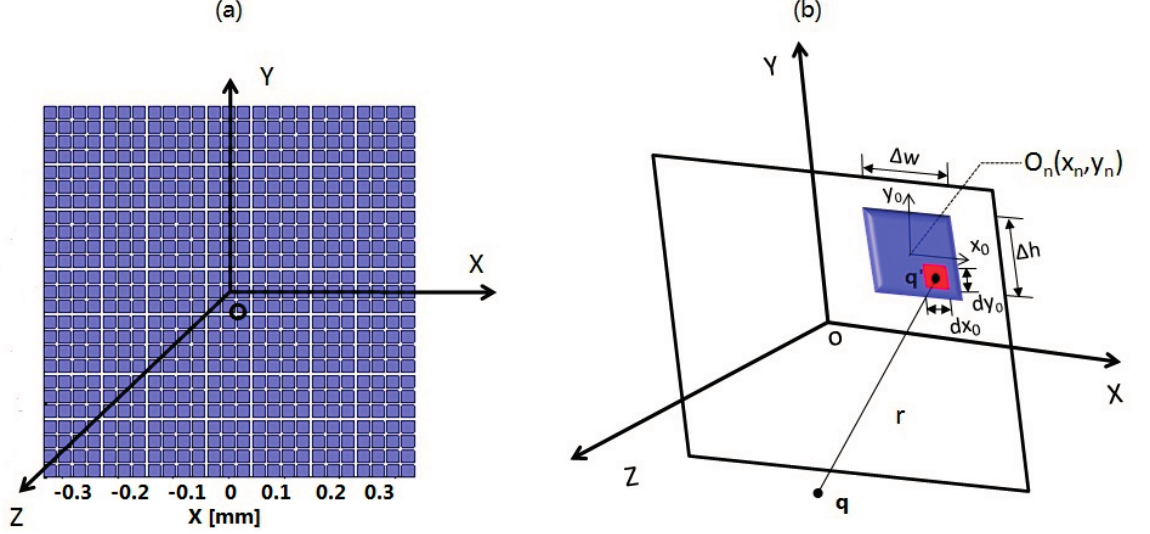
Figure 3. Configuration and geometry for the phased array sensor ( a ) Phased array sensor with 25 × 25 elements; ( b ) Coordinate system for the calculation of the acoustic